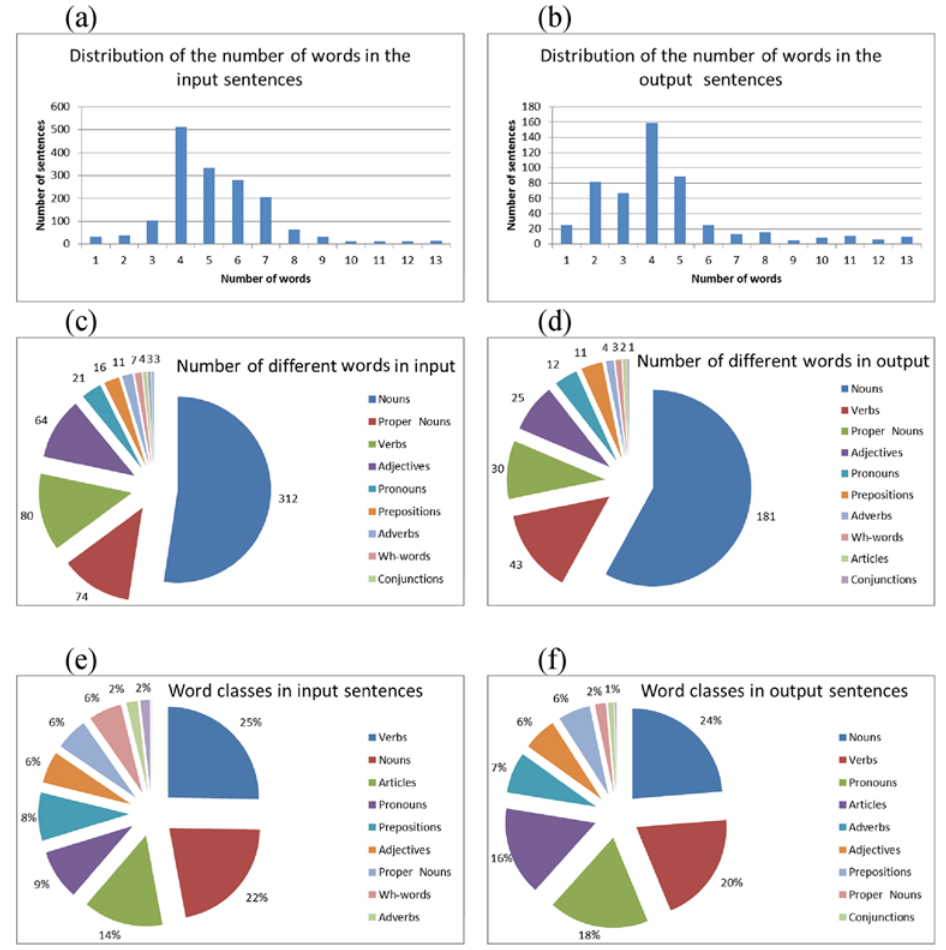
Fig 8. Distribution of the number of words and of the word classes in the input and output sentences. Distribution of the number of words in the input sentences (a) and in the output sentences (b); distribution of the words used in the input and output sentences among different word classes (c,d); percentage of word classes in the input and output sentences (e,f).